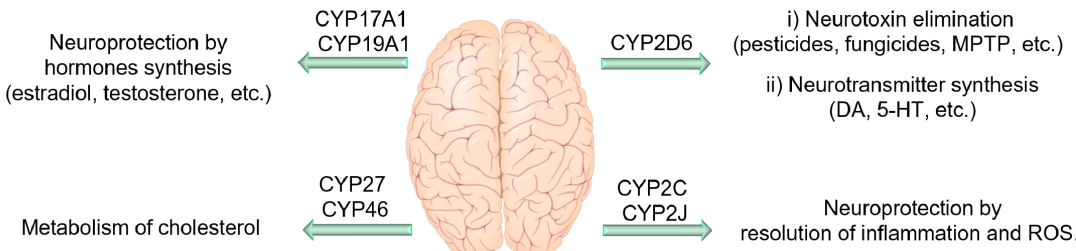
Figure 4. The protective role of some cytochrome P450s (CYPs) in neurodegenerative diseases. Abbreviations- CYP: cytochrome P450, DA:dopamine, 5-HT: 5-hydroxytryptamine (or serotonin),